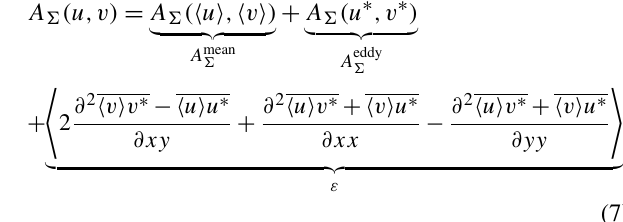
hidden inside the vertical and time